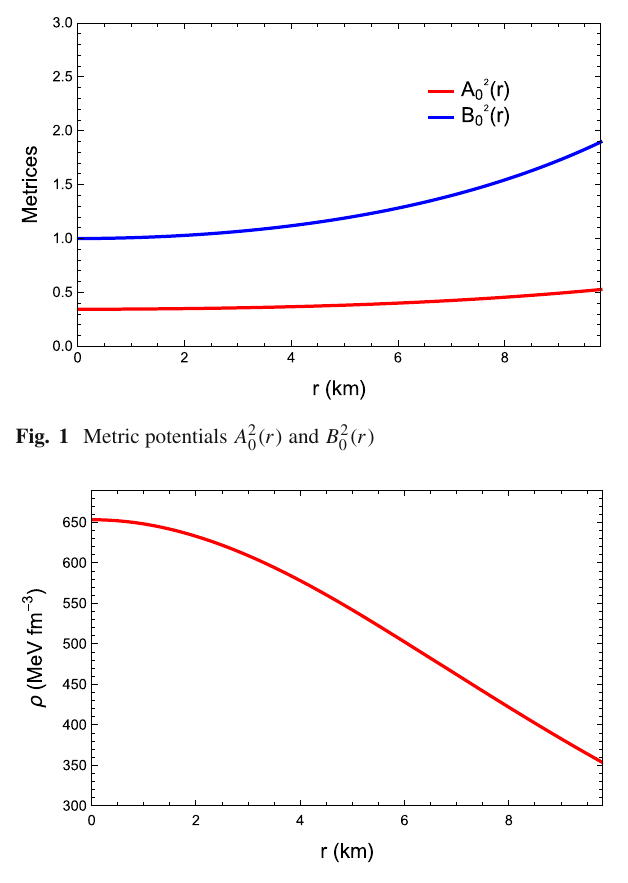
Fig. 2 Density profile